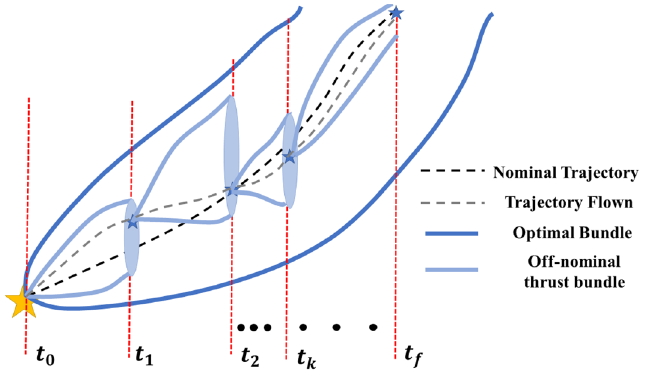
Figure 8. A schematic describing GPR based guidance of spacecraft with off-nominal thruster